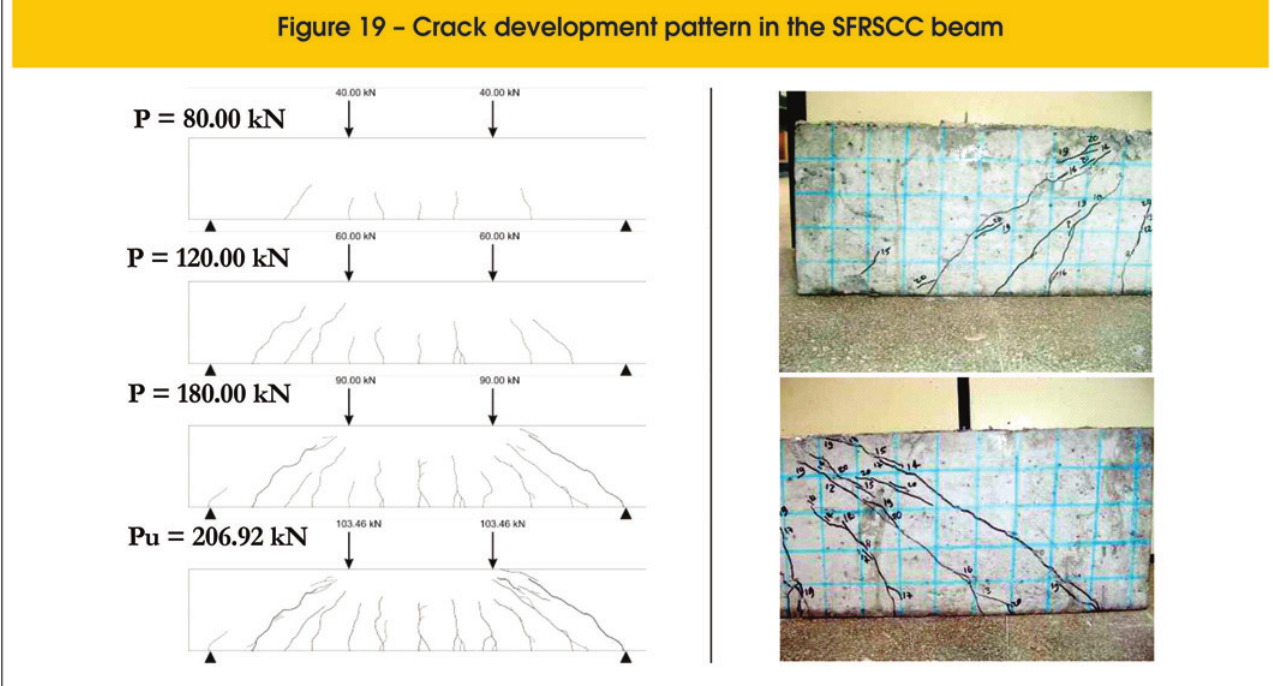
This gives evidence of some kind of fiber reinforcement in this sense. As for the RC beam, the development of cracks progressed as represented in Figure